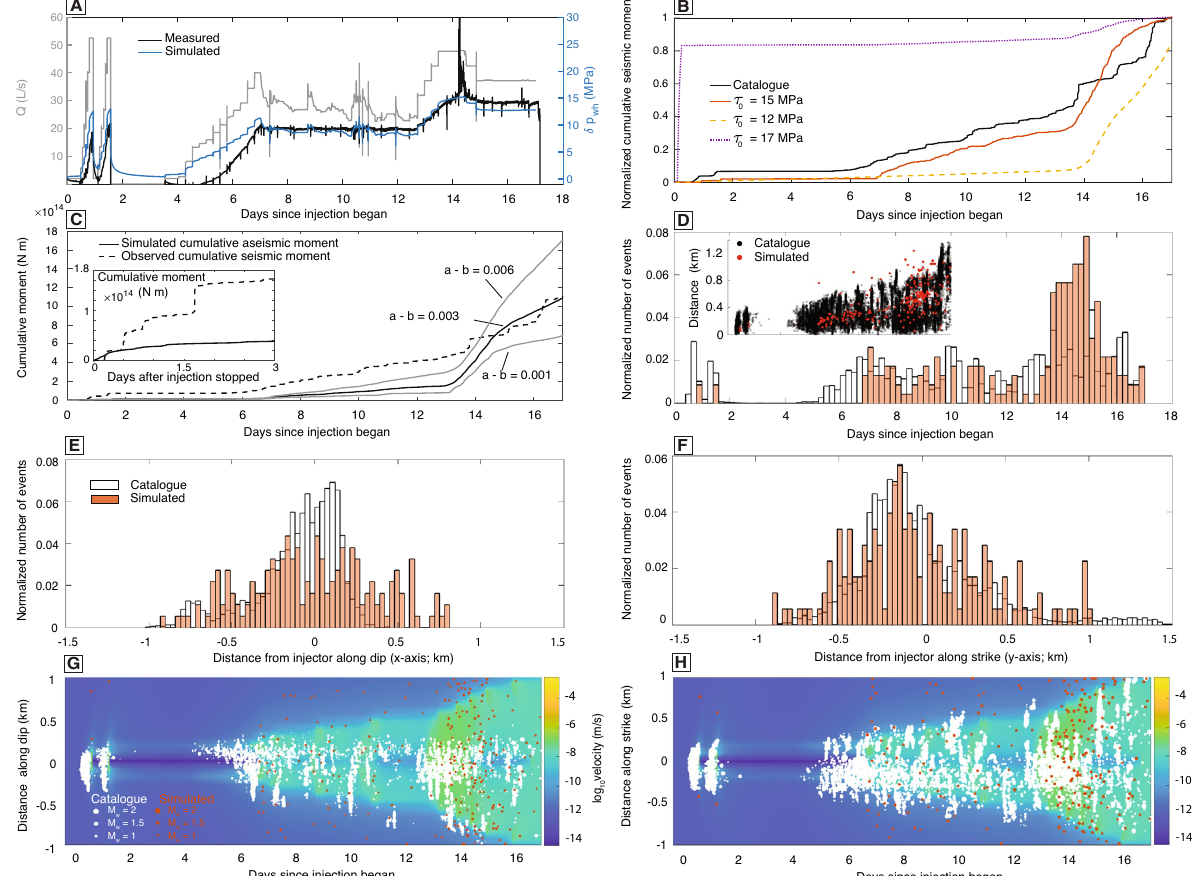
Figure 2. ( A ) Injection rate and wellhead pressure at Habanero 4 from Nov. to Dec. 2012. ( B ) Simulated cumulative moment due to seismic slip for initial shear stress of 12, 15, and 17 MPa, as well as cumulative moment derived from seismic catalog. Both are normalized by total moment. ( C ) Cumulative seismic moment derived from microseismicity catalog and cumulative aseismic moment from simulation. b . Inset shows the cumulative seismic/ Simulated cumulative aseismic moment is shown for different a − aseismic moment after injection stopped (note that cumulative moment axis is a factor of 10 smaller). ( D ) Number of seismic events per time interval normalized by total number of events. Inset shows the migration of seismicity away from the well. ( E ), ( F ) Number of seismic events per distance interval along dip and strike, respectively, normalized by the total number of events. The events along each axis are restricted to within 100 meters from the well along the other axis. ( G ), ( H ) Time evolution of seismicity (dots) and main fault slip velocity (color), along dip and strike, respectively. All results are for an initial shear stress of 15 MPa and main 0.003 , unless otherwise b fault a − = (Fig. 3C). If the near-well permeability is the same as the lower permeability away from the well, the model over- predicts the amplitude of the pressure peaks in days 1 and 2 (Fig. 2A). A lower permeability away from the well is simultaneously required. If the permeability away from the well is the same as the higher permeability near the well, the model underpredicts the amplitude of the pressure plateaus during days 7 to 17. We note that a simi- larly sized region of enhanced permeability was found for the 2003 stimulation of the nearby Habanero 1 well 32 . We then calibrate the initial shear stress, τ 0 , on the main fault and secondary faults. The closer secondary faults are to being critically stressed, the more seismicity occurs at the beginning of injection period. A lower 15 MPa, initial shear stress results in more seismicity occurring at the end of injection period. We find that τ 0 = 10.3 MPa implied by the estimated S Hmax and S v , is required to explain the observed seismicity. higher than τ 0 = The choice of τ 0 on the secondary faults strongly influences the temporal distribution of seismic events, as well as the temporal trend of total seismic moment release (Fig. 2B). Because the simulated seismicity rate depends on the number of secondary faults, which for computational reasons is much fewer than the observed number of events, we focus our comparison on the temporal trend of cumulative seismic moment, normalized by the cumulative seismic moment at the end of injection. We use τ 0 / f ∗ σ ′ 0 as the proxy for closeness-to-failure, where f ∗ 0.6 is the reference friction coefficient at reference velocity V ∗ 1 10 − 6 m s − 1 , representative of aseis- = = × σ 10 MPa ( τ 0 / f ∗ σ ′ p 0 is the initial effective normal stress. At τ 0 0.6 ), no mic slip velocities, and σ ′ 0 0 ≈ = = − 12 MPa ( τ 0 / f ∗ σ ′ 0.7 ), most events occur after day 14, seismicity (slip velocity > 0.1 m/s) is induced. At τ 0 0 ≈ =